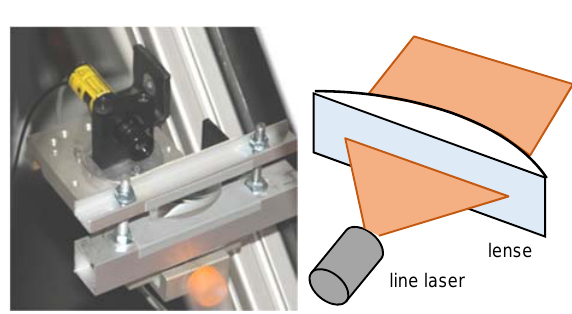
Figure 16: Setup of a laser line module together with a cylinder lens (5cm), telecentric projection